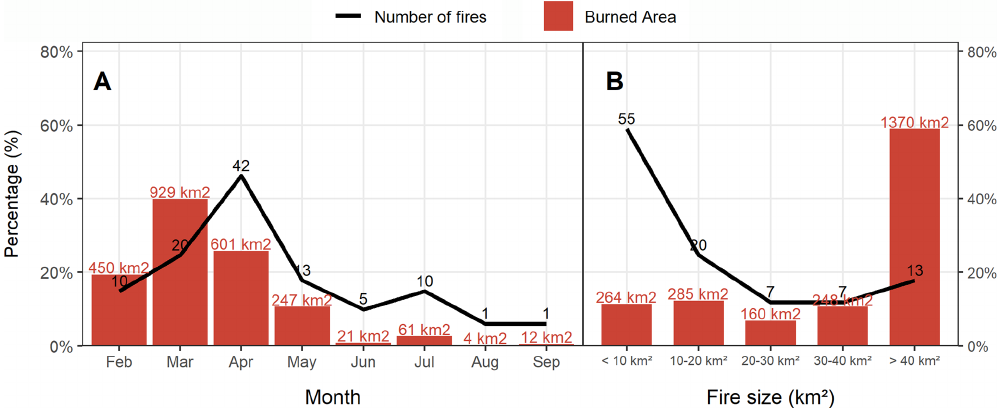
Figure 3. Burned area percentages for northwest Europe calculated (a) monthly and (b) according to size distribution at the time the fire ended. Burned area may differ from that detected by other remotely sensed burned area products or delineated in the GIS systems maintained by fire managers because of the spatial resolution limitations of the active fire product used in this work (VNP14IMGTDL_NRT; https: //firms.modaps.eosdis.nasa.gov/download/, last access: August